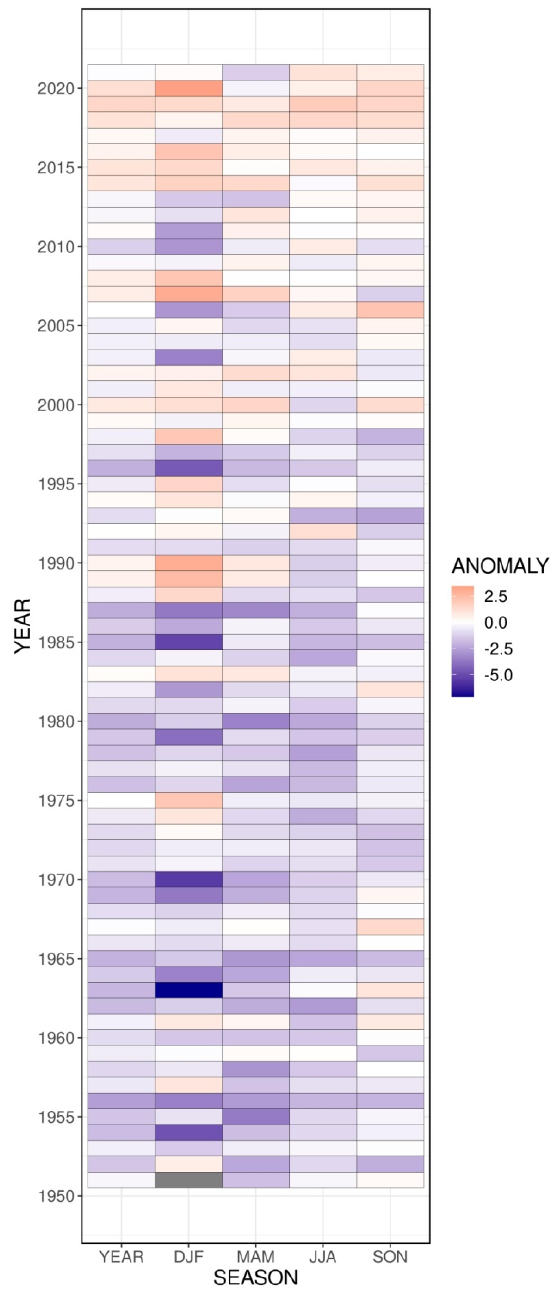
Figure 2. Air temperature anomalies (°C, with reference to the 19912020 normal period) in Poland 19512021.